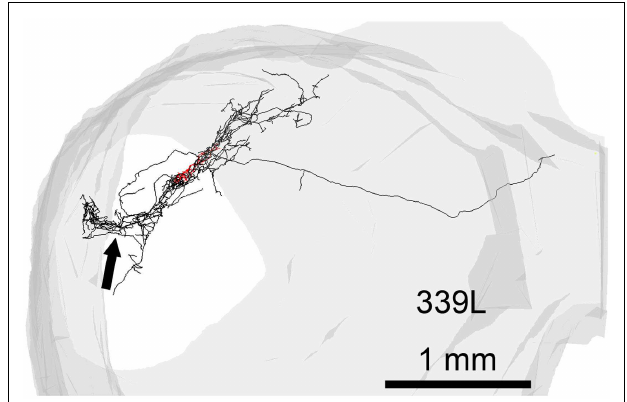
FIGURE 7 | Reconstruction of the axon (black) and dendrites (red) of a single cell (339L) viewed in an oblique plane optimized to show how the branches of the intralaminar intrinsic axon bend round to follow the upward sweep of the lamina at the lateral edge (black arrow).